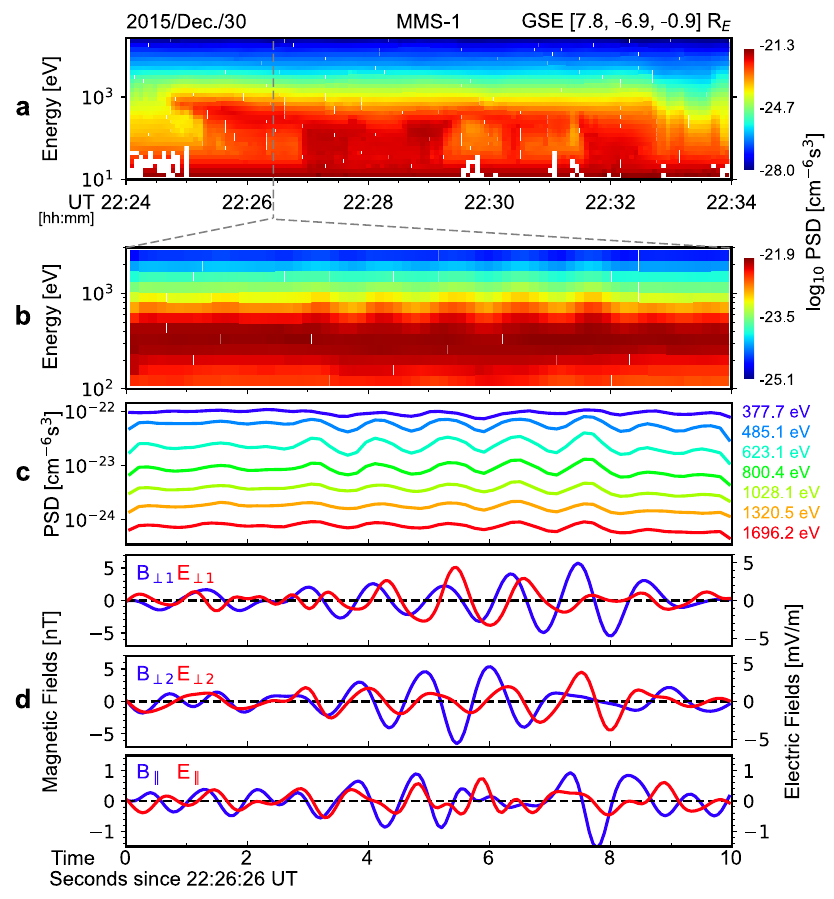
Fig. 2 | Overview of the KAW-proton interaction event on December 30, 2015. a The looking direction-averagedphase space densities ofprotons as a functionof time and energy. b An expanded view of panel a, in which KAW-associated